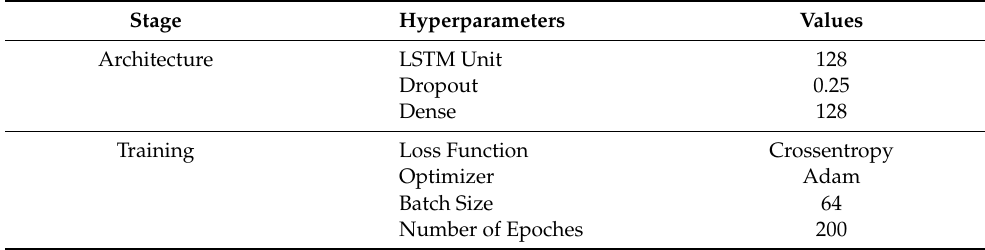
Table 6. The summary of hyperparameters for the LSTM network used in this work.